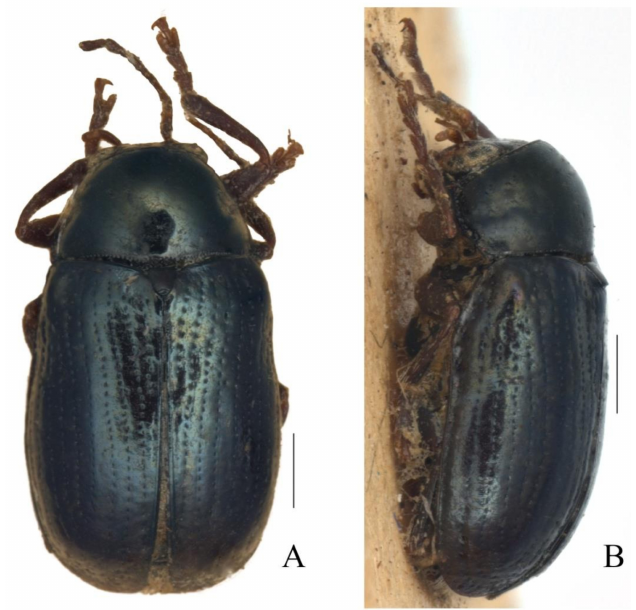
Figure 10. Cryptocephalus ( Burlinius ) aphthonoides Chen, 1942: ( A ) habitus; ( B ) lateral view of habitus; (Scale bars: 0.5 mm) (holotype, female).